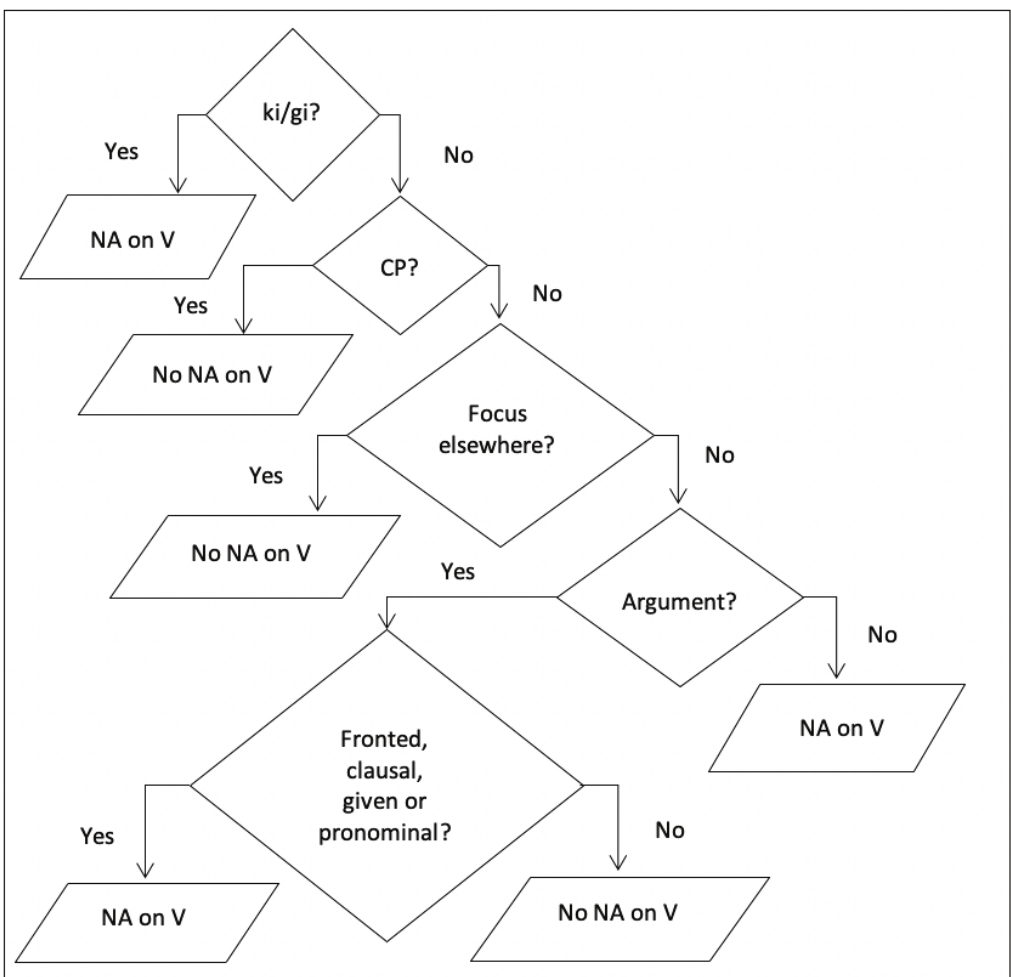
Figure 4. The decision procedure. Abbreviations: CP - complex predicate, NA - nuclear accent, V - finite